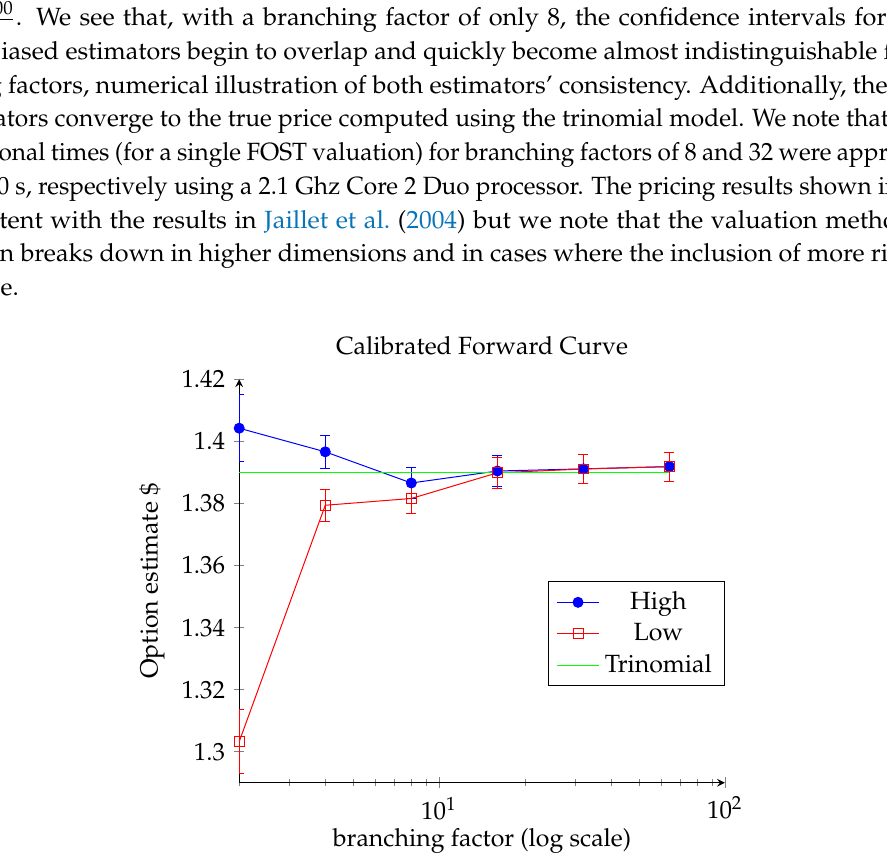
Figure 4. Option-value estimates versus (log) branching factor. Approximate pointwise 95% confidence intervals for each estimate are given by the vertical bars. The option and underlying model in this example is from Jaillet et al. (2004) with the Trinomial price given by their Forest of Trinomial Trees